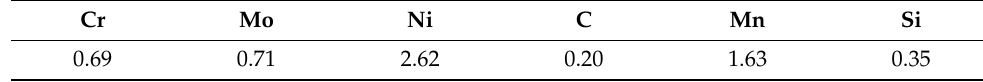
Table 1. Chemical composition of WM (wt%).